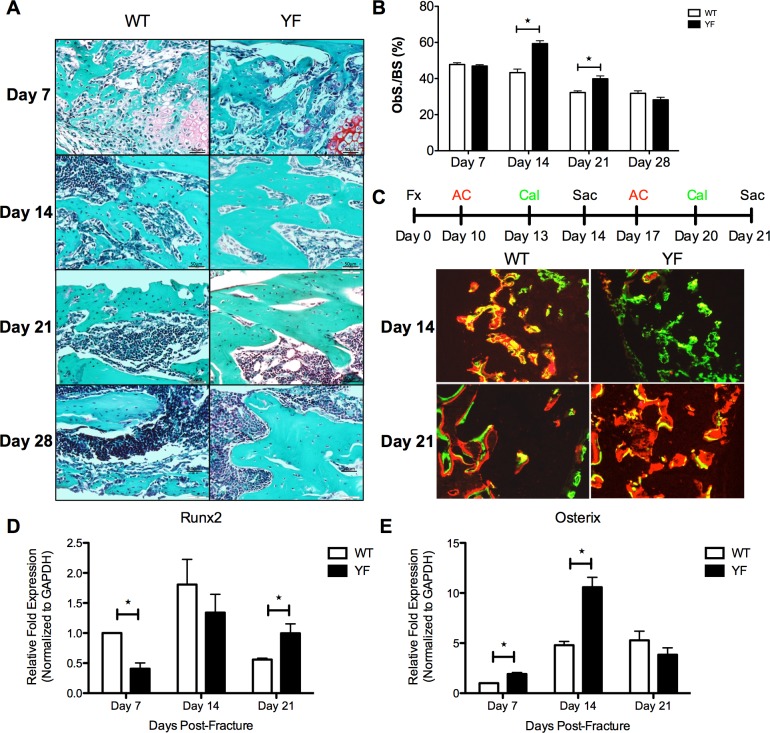
Lack of Cbl-PI3K interaction results in increased osteoblast surface, incorporation of dynamic bone labels, and up-regulation of master transcription factor Osterix in remodeling fracture calluses.Mid-saggital sections of fractured femora were stained with Safranin O and Fast Green, and counterstained with Hematoxylin. A. Representative sections at 7, 14, 21, and 28 days post-fracture showing bony regions of fracture calluses. B. Osteoblast surface over bone surface (ObS/BS) measured by static histomorphometry. n = 6, *p<0.05 vs. WT. C. Mice were injected with Alizarin Complexone (red) 4 days prior to sacrifice, and Calcein (green) 1 day prior to sacrifice. Mid-sagittal sections of fractured femora were used to image incorporation of dynamic bone labels in the center of the fracture calluses at 14 and 21 days post-fracture. Cells from sections of calluses at 7, 14, and 21 days post-fracture were harvested by LCM, and expression of D. Runx2, and E. Osterix were quantified by qRT-PCR n = 6, *p<0.05 vs. WT.